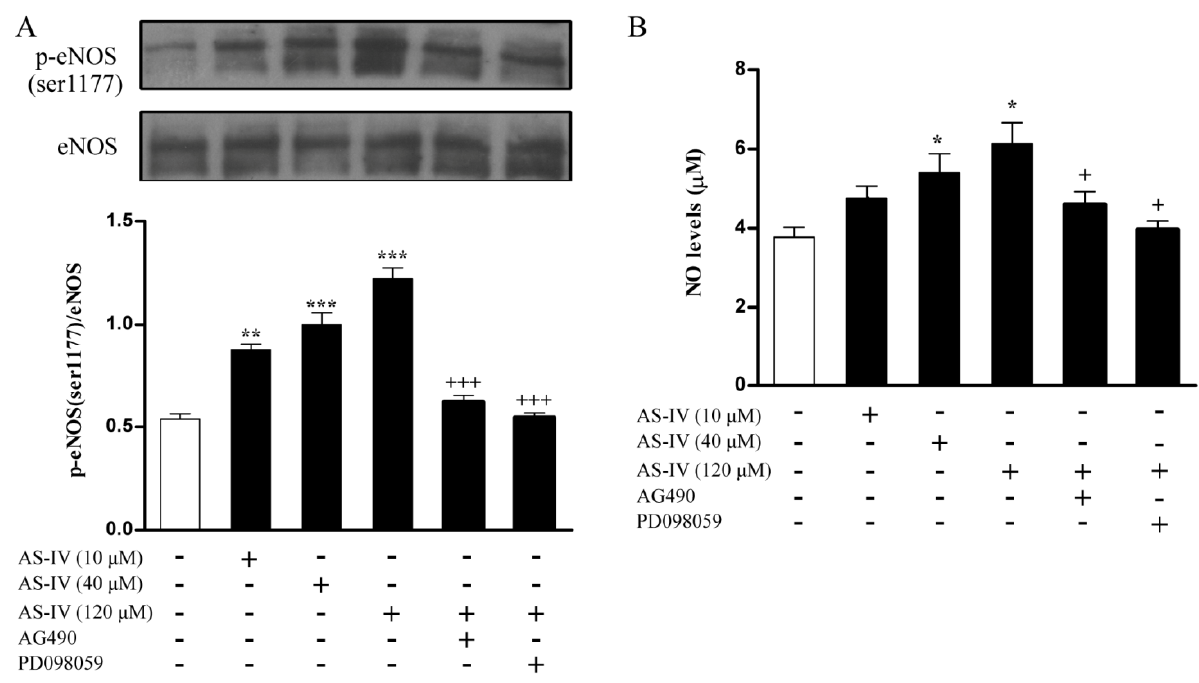
Figure 4. AS-IV upregulates NO via JAK2/STAT3 and ERK1/2 pathway. ( A ) Serum-starved HUVECs were treated with AS-IV (10-120 μ M) for 30 min or pretreated with AG490 (100 μ M) and PD098059 (10 μ M) for 1 hour before incubation with AS-IV (120 μ M) for 30 min. Cellular lysate was used to measure phosphorylated eNOS (Ser1177) levels by Western blot. ( B ) Serum-starved HUVECs were treated with AS-IV (10-120 μ M) for 30 min or pretreated with AG490 (100 μ M) and PD098059 (10 μ M) for 1 hour before incubation with AS-IV (120 μ M) for 30 min. The stable end product of NO, nitrite, was measured in the medium using the Griess reaction. Medium total nitrite content corrected for protein content of the cell layer was estimated according with the company